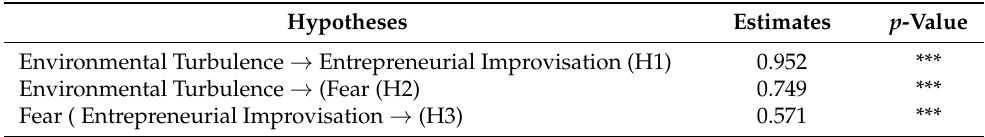
Table 6. Hypotheses testing—direct effects.